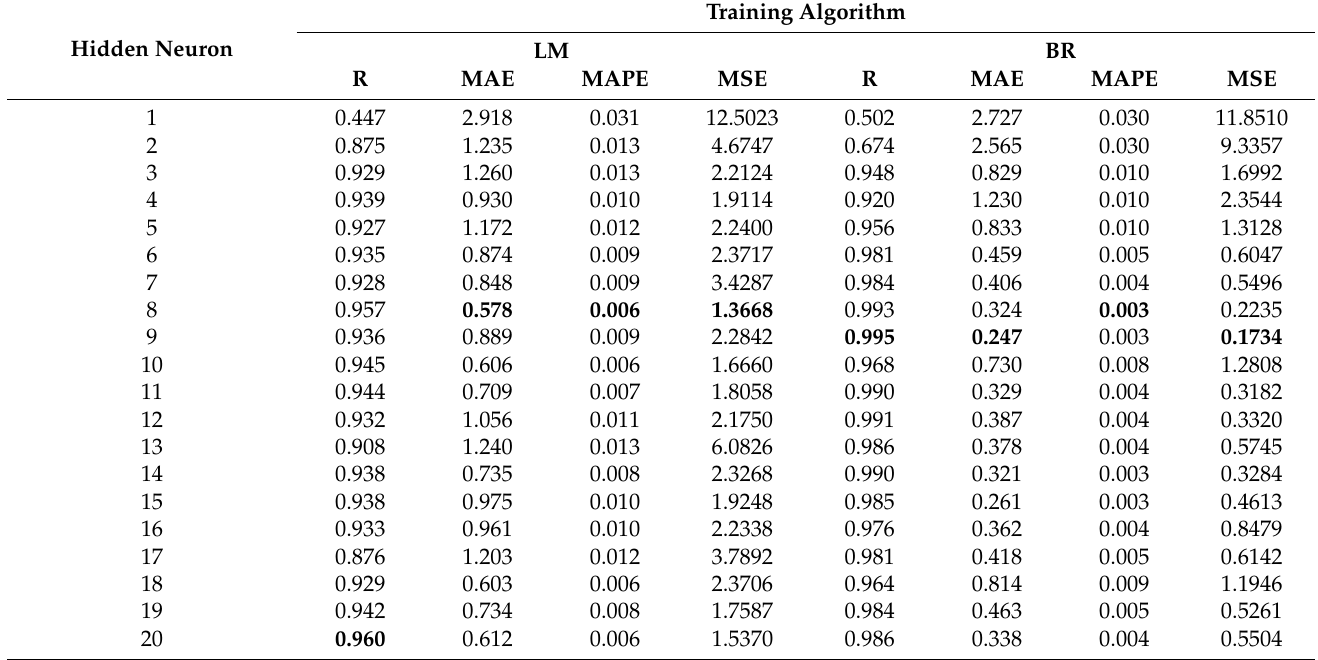
Table A20. R, MAE, MAPE, MSE value for BOD removal for different training algorithms at different number of hidden neurons (aerobic